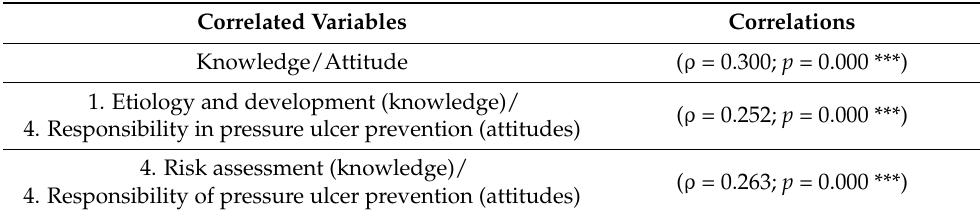
Table 3. Significant correlations among